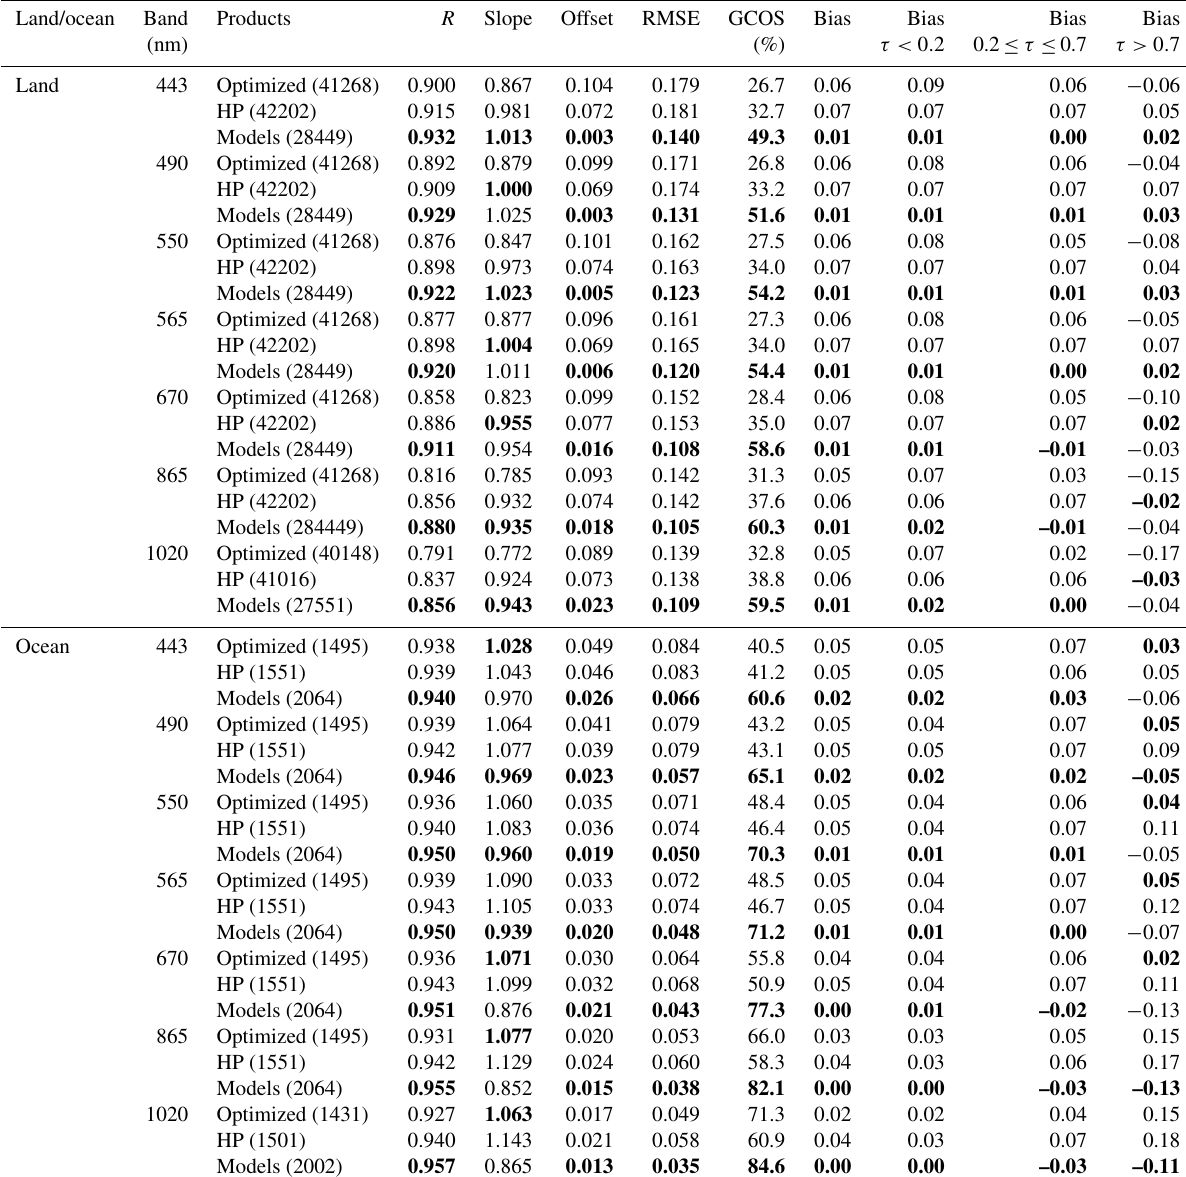
Table 3. Global statistics of PARASOL/GRASP spectral AOD vs. AERONET AOD over land and ocean. The best performing of three approaches by each metric is labeled in